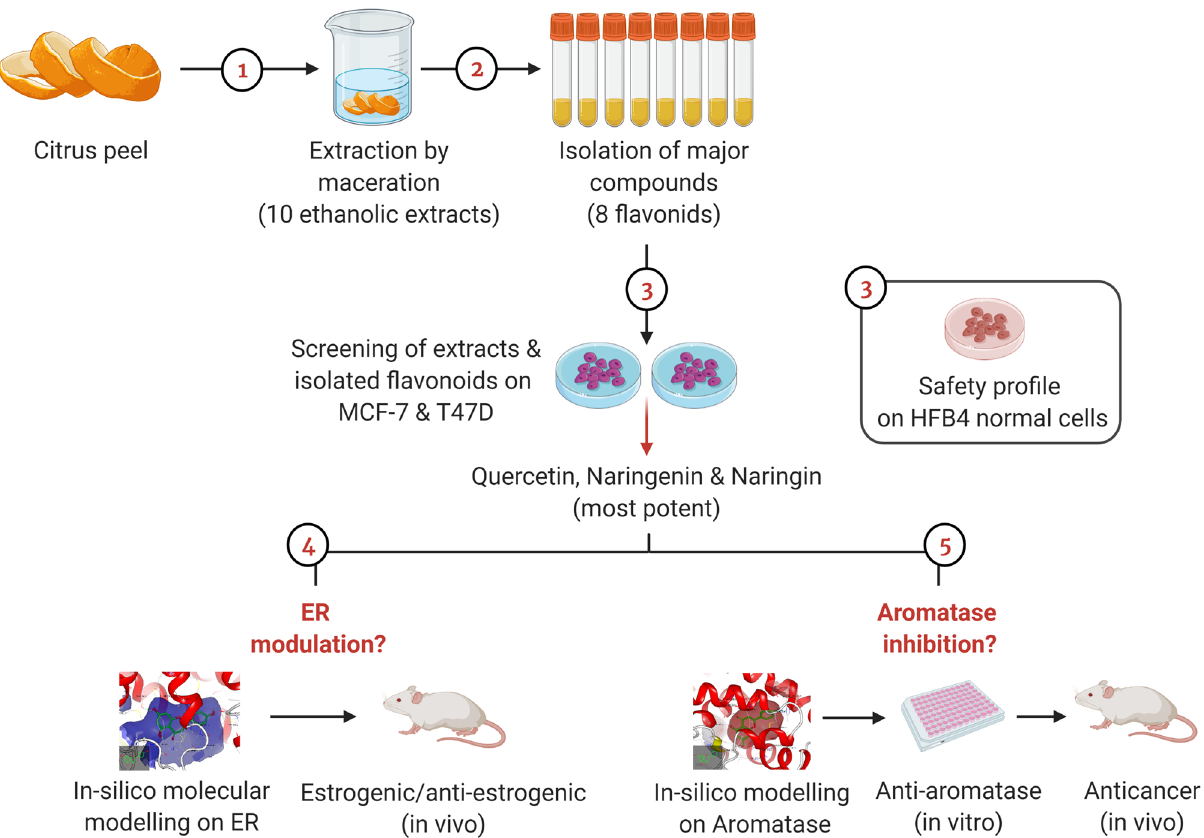
Figure 6. Schematic diagram outlining the sequential steps adopted in the present study. Extraction by maceration was performed for different varieties of different citrus peels. The ethanolic extracts alongside eight isolated flavonoids were screened against estrogen-dependent breast cancer cell lines (MCF-7 and T47D) as well as HFB4 normal cells for evaluating the safety profile. Naringenin, naringin and quercetin were found to be the most potent and were thus selected for further assays. The experiments performed had two arms which aimed at investigating estrogen receptor (ER) modulation and aromatase inhibition potential of the three most potent compounds. To achieve this aim, molecular docking against ER was performed followed by in vivo estrogenic and anti-estrogenic assays for the isolates. Moreover, molecular docking against aromatase enzyme was performed for the three compounds followed by in vitro aromatase inhibition. Then, investigation of the in vivo anticancer activity was executed along with estimating aromatase levels in solid tumors. This figure was created using BioRender software (www. biore nder.